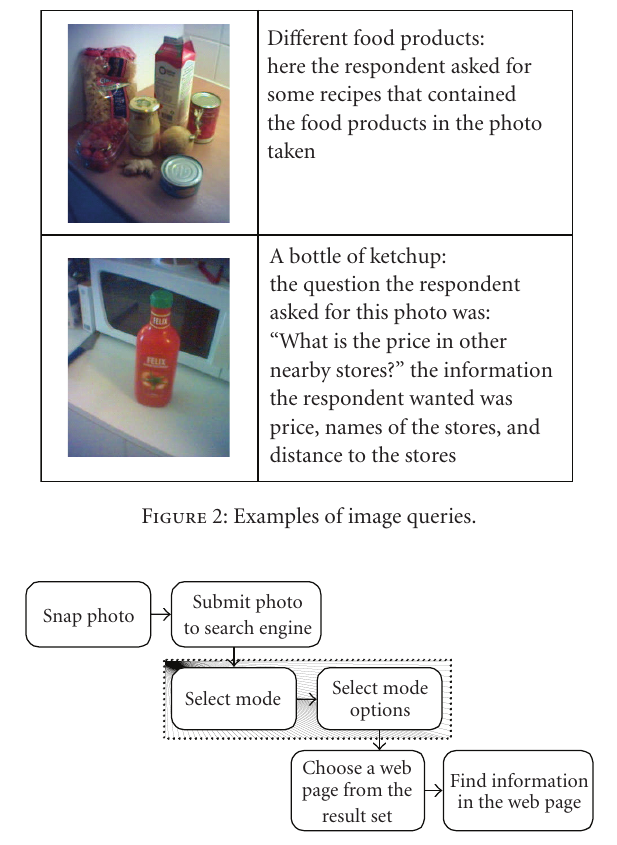
Figure 3: Interaction sequence of an image-based search using search modes. The two steps marked in the middle of the sequence are what di ff erentiate it from a straight image-based